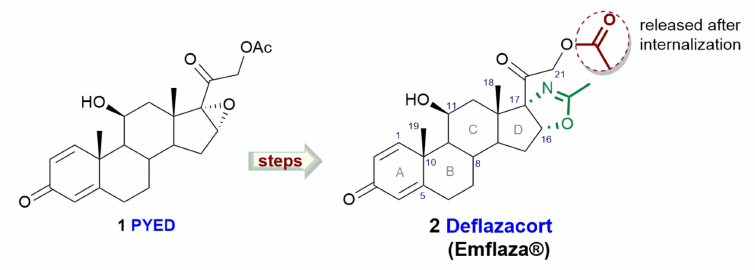
Figure 1. Deflazacort and its synthetic precursor PYED-1 (pregnadiene-11-hydroxy-16 α ,17 α